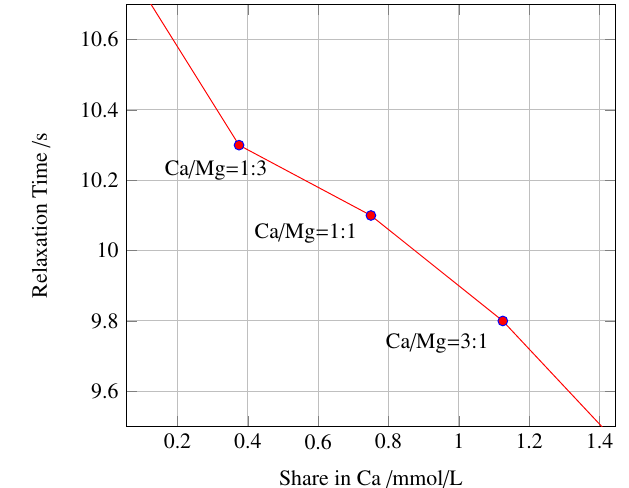
Table 4. MTP frequencies of the impedance spectras of Fig.12.